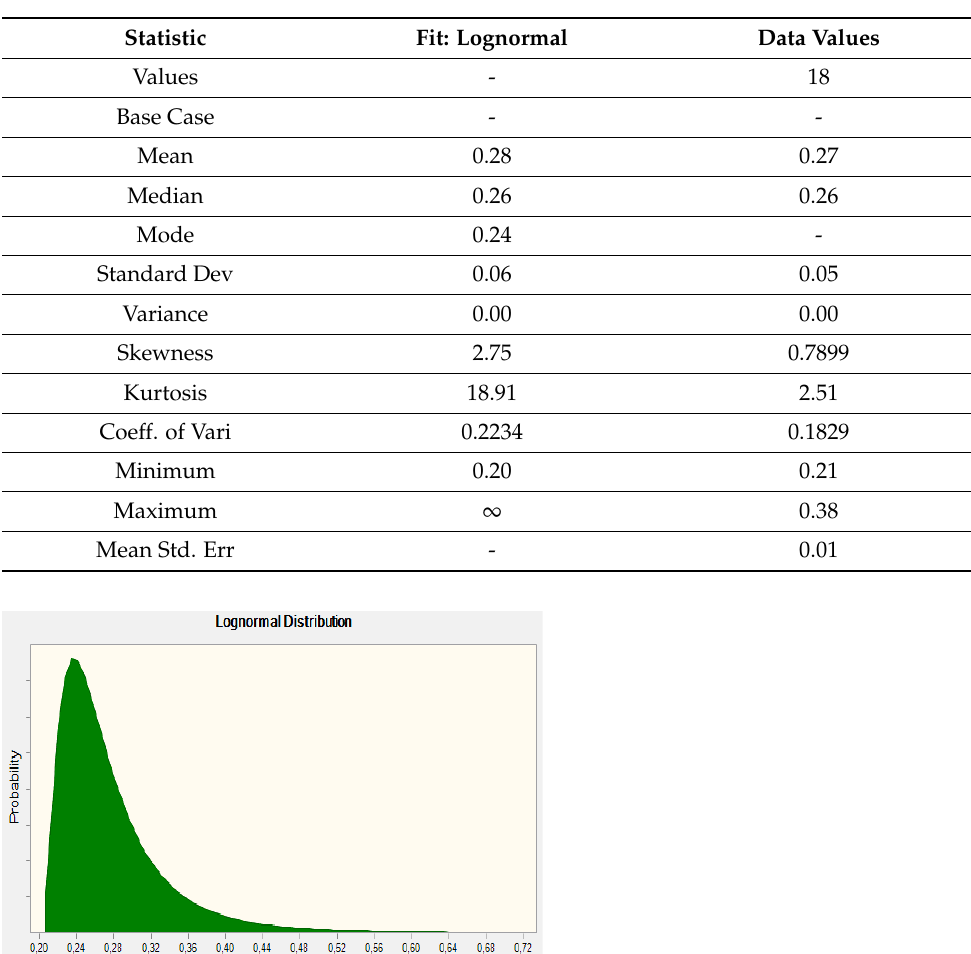
Table 1. Descriptive statistics of probability distribution for accommodation facilities’ occupancy in Bratislava.